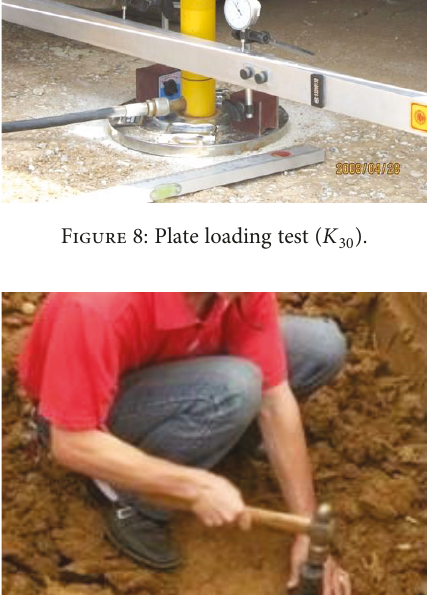
Figure 9: Ring sampler test